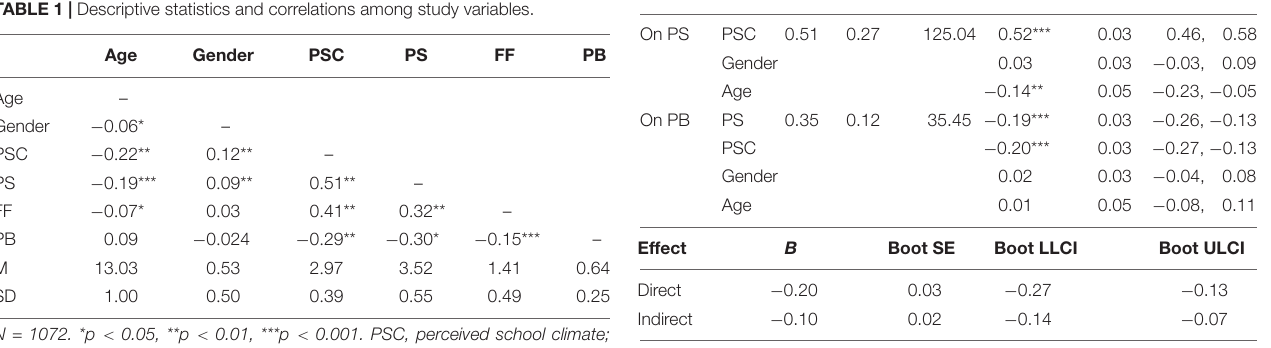
TABLE 1 | Descriptive statistics and correlations among study variables.